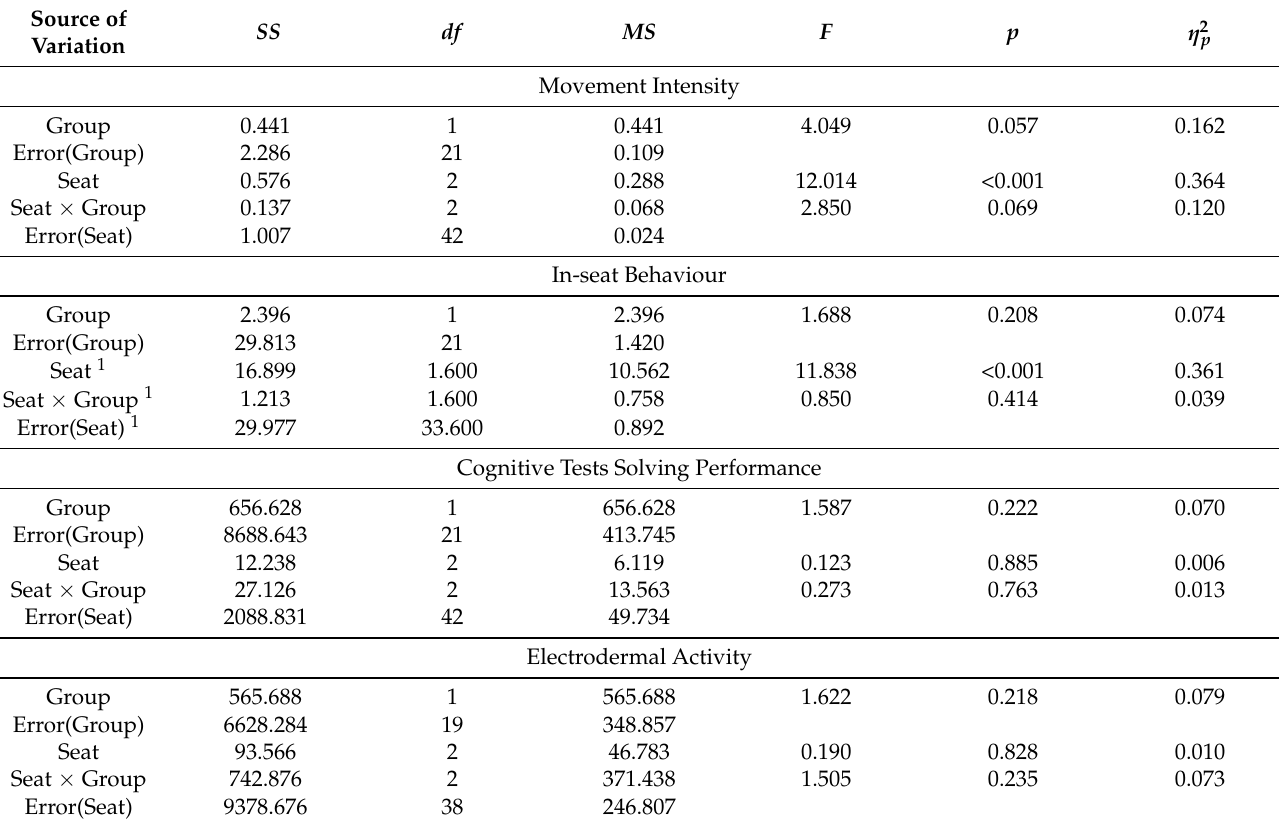
Table 5. Two-way ANOVA for factors Group and